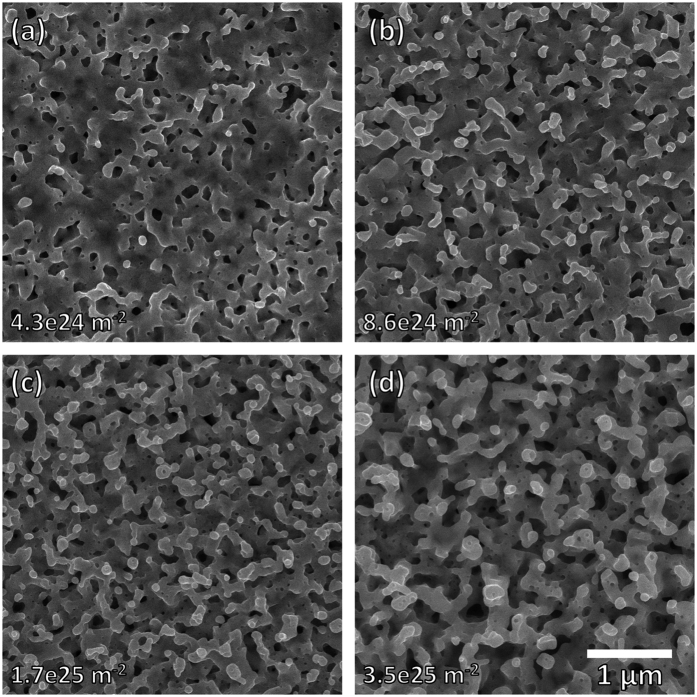
SEM micrographs surfaces irradiated at 1223 K with 100 eV He+ ions to fluences of (a) 4.3 × 1024, (b) 8.6 × 1024, (c) 1.7 × 1025, and (d) 3.5 × 1025 ions m−2.